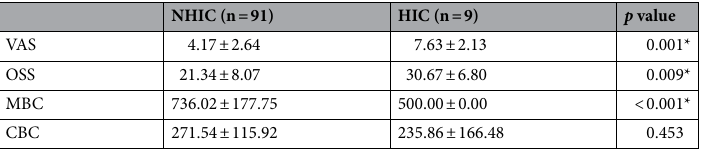
Table 1. Clinical parameters of interstitial cystitis/bladder pain syndrome subtypes. * p < 0.05 by independent samples t-test. NHIC Non-Hunner’s interstitial cystitis, HIC Hunner’s interstitial cystitis, VAS visual analog score for pain, OSS score O’Leary-Sant Symptom score, MBC Maximal bladder capacity, CBC cystometric bladder